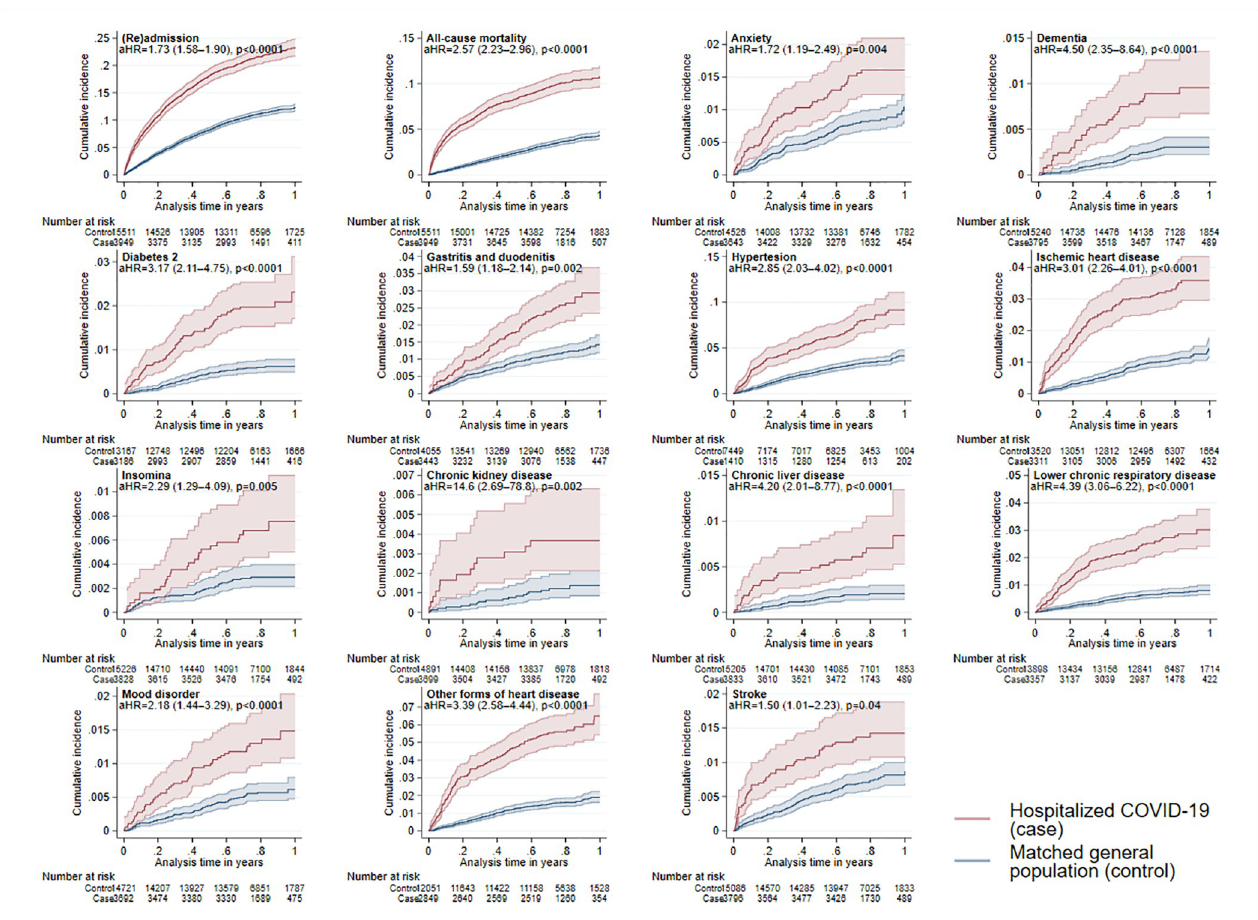
Fig 2. Kaplan-Meier curves for the comparison of the significant outcomes during 12 months comparing hospitalized COVID-19 patients (red curves) and matched general population (blue curves). Shaded zones indicate 95% CI.